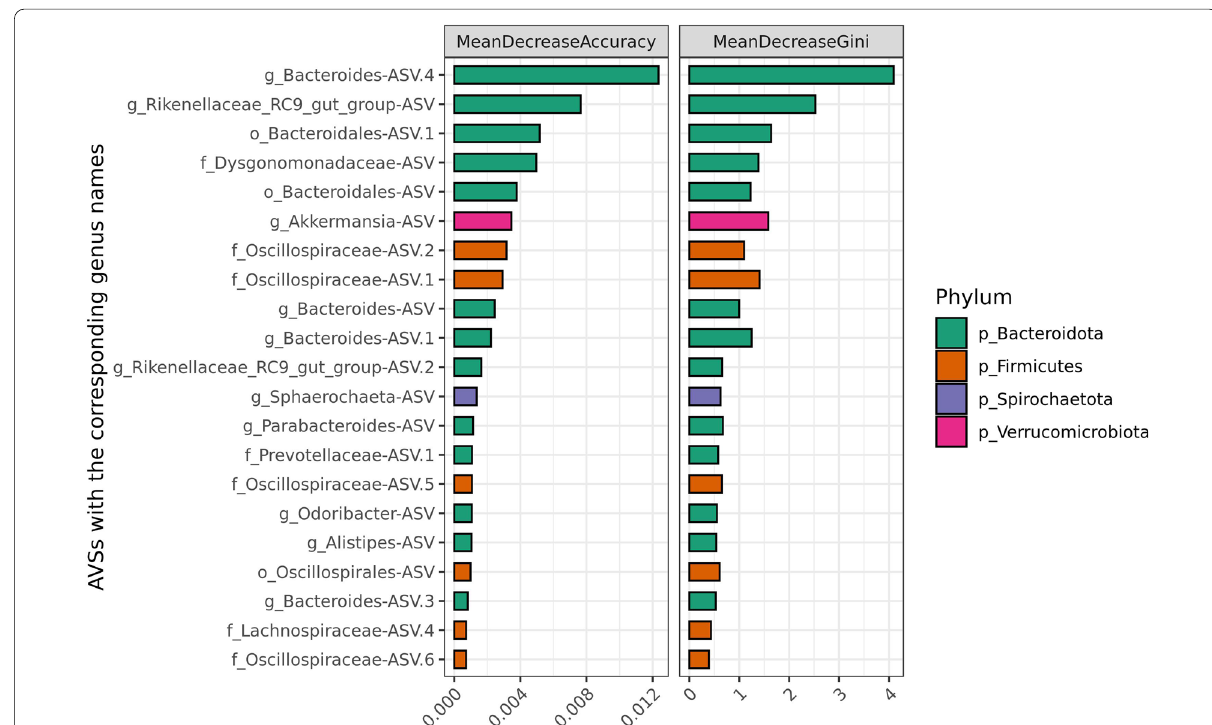
Fig. 4 Top 21 ASVs with the highest contribution to Random Forest classification accuracy. ASVs named by a corresponding genus, or lowest available taxonomic classifier as indicated by prefix letter